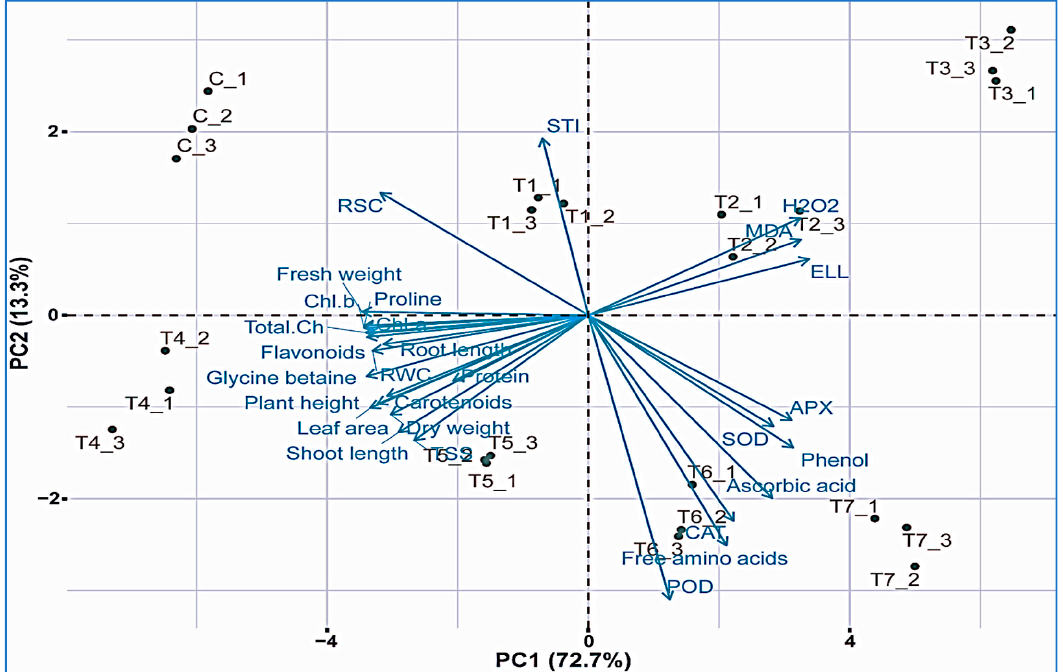
Figure 8. Cluster analysis and PCA biplot analysis between biochemical parameters and antioxidants with plant biomass parameters under various salt increments; shoot length, root length, plant height, fresh weight, dry weight, leaf area, chlorophyll a (Chl a), chlorophyll b (Chl b), total chlorophyll (T. chl), carotenoids, superoxide dismutase (SOD), peroxidases (POD), catalase (CAT), ascorbate peroxidase (APX), ascorbic acid, phenolic content, flavonoid content, relative water content (RWC), electrolyte leakage (ELL), glycine betaine, proline content, protein content, total soluble sugars (TSS), malondialdehyde (MDA), hydrogen peroxide (H 2 O 2 ), salt tolerance index (STI), radical scavenging capacity (RSC), and free amino acids.